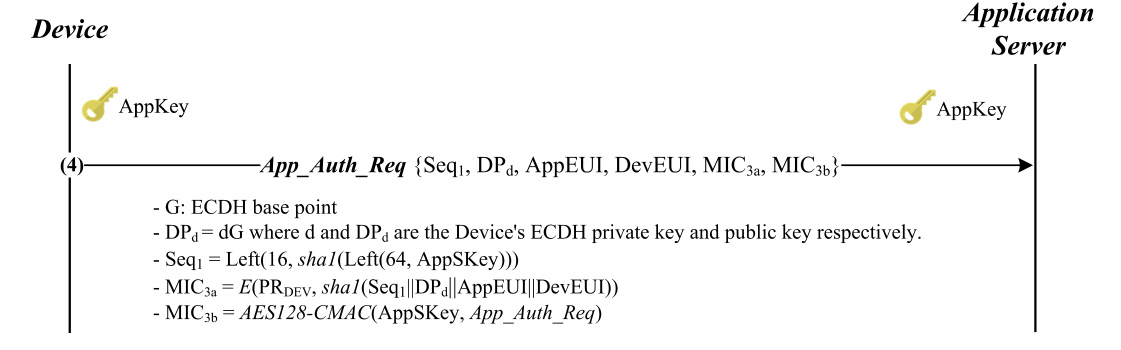
Figure 5. Proposed protocol’s security-enhanced